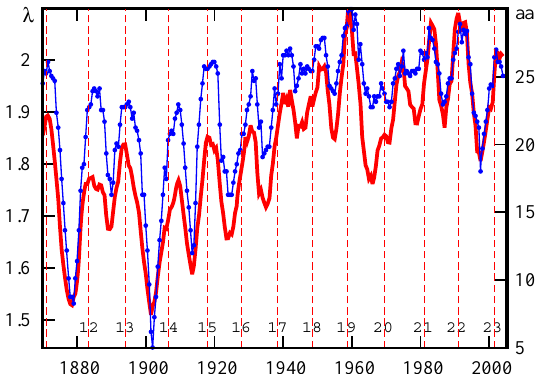
Figure 10. Red curve: the daily aa averaged over 4 years. Blue curve: the irregularity index computed in a 4-year sliding window with m =1. Vertical dashed lines are at the maxima of Wolf num- bers (averaged over 4 years). The number of each Schwabe cycle is